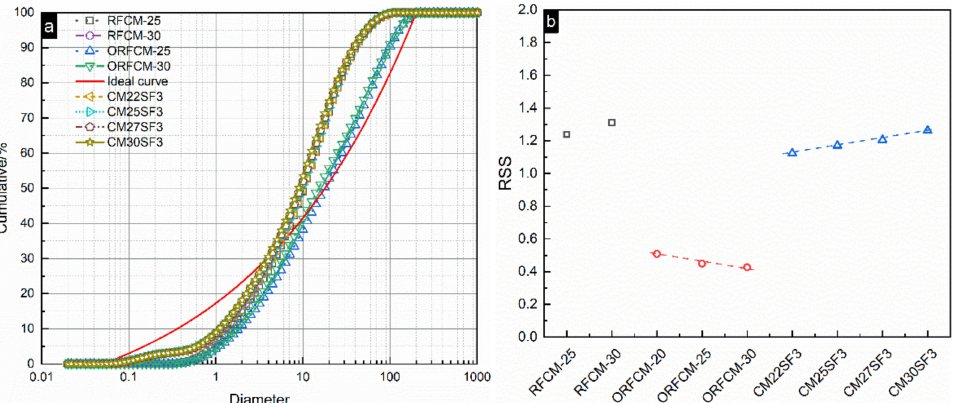
Figure 14. Particle size distribution (PSD) of reverse filling system and ideal system ( a ) and the residual sum of squares (RSS) value ( b